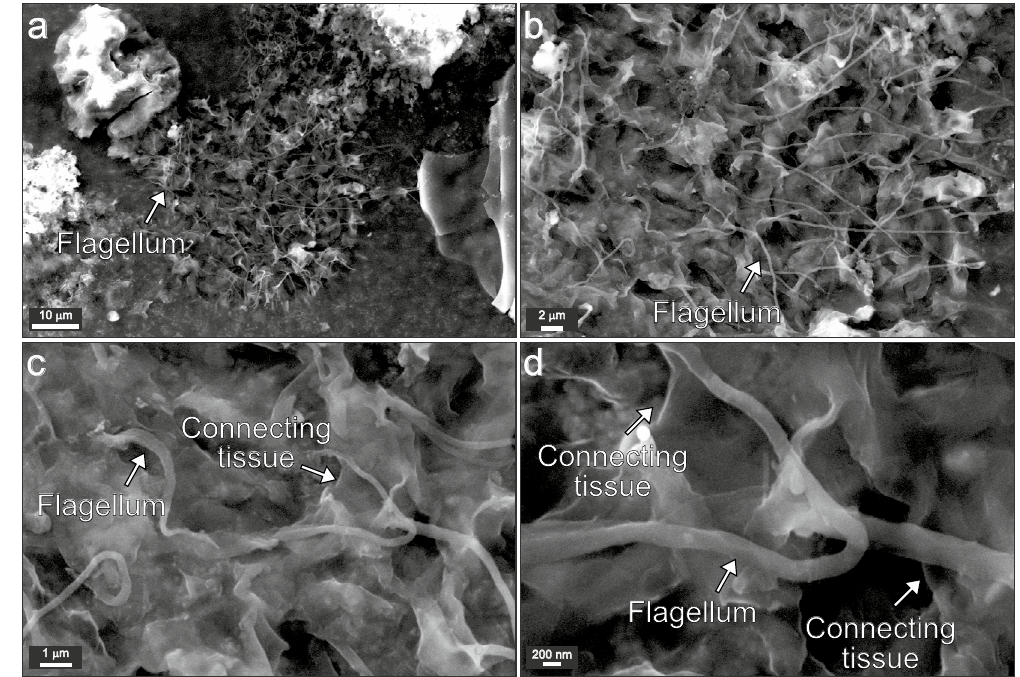
Figure 4. Scanning electron microscopy analysis. ( a , b , c , d ) Photomicrographs of colonial choanoflagellate from the Capas Blancas Mb. ( R. cushmani Biozone) at Baños de la Hedionda, highlighting the flagellum and the connecting tissue that joins the individual cells of the colonial